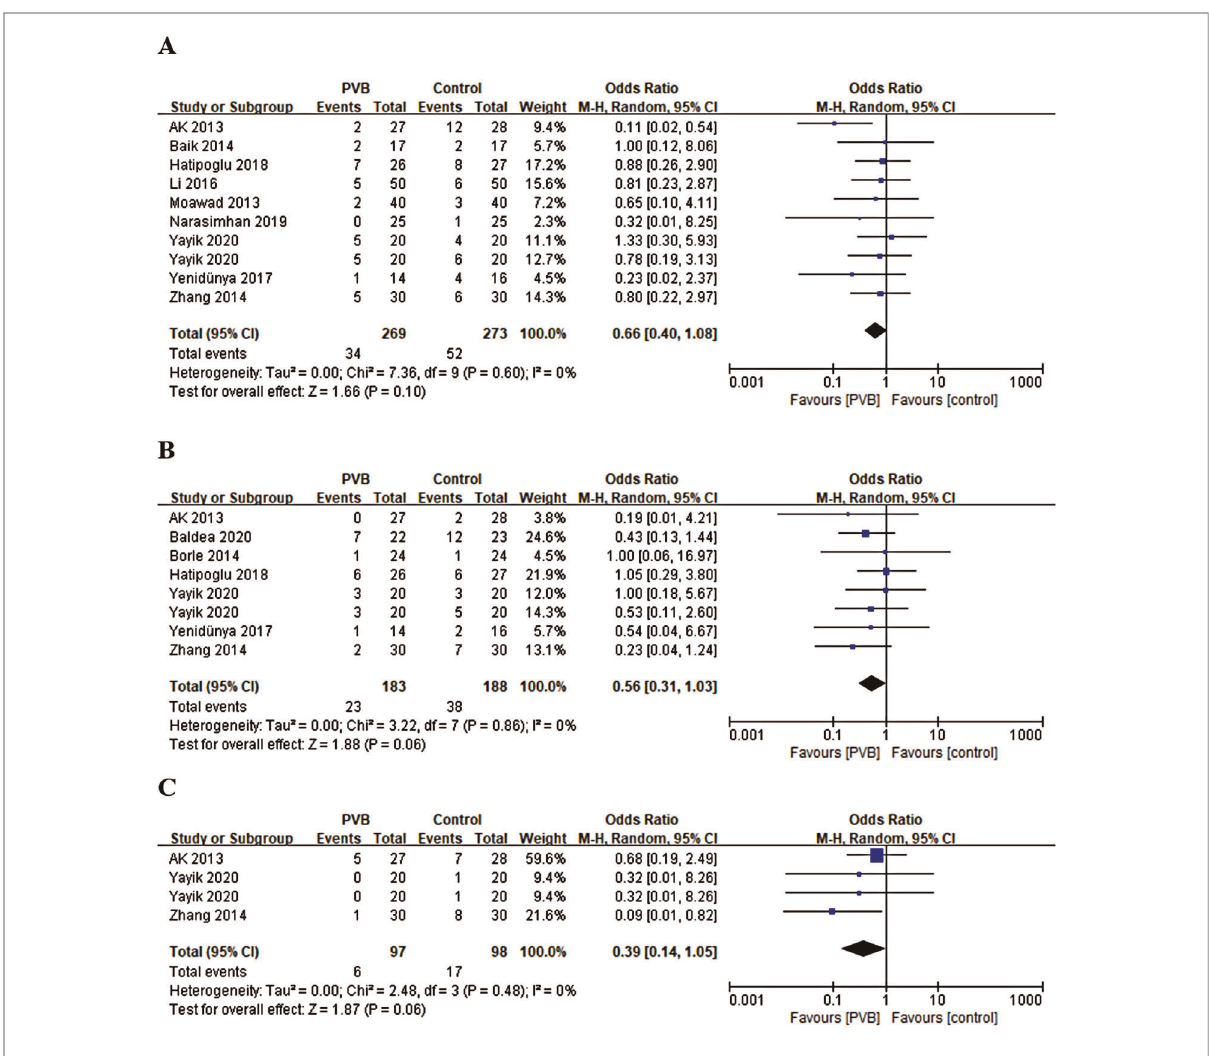
FIGURE 8 Forest plot of the incidence of ( A ) nausea, ( B ) vomiting, and ( C )